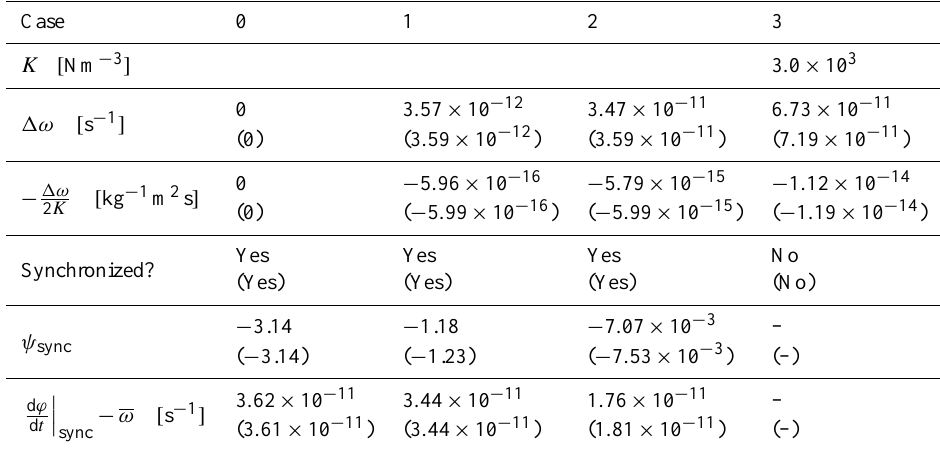
Table 1. The synchronization properties of some pairs of coupled oscillators with different parameter settings. The corresponding values estimated from the PCF are shown in